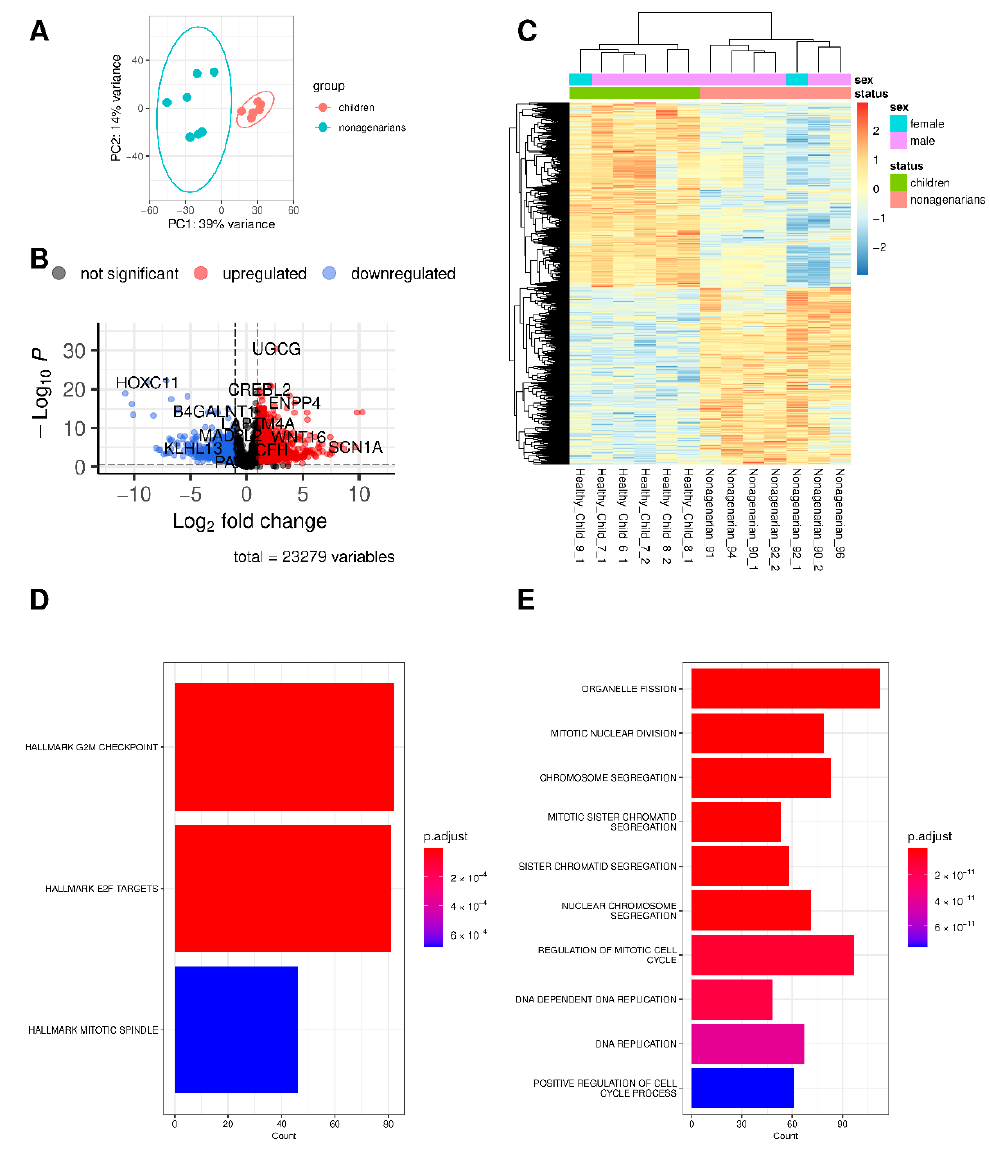
Figure 2. Comparing gene expression in RNA sequencing data of nonagenarians and healthy children (normal/chronological aging). ( A ) Principal Component Analysis (PCA): nonagenarians (blue dots) compared to healthy children (controls, red dots). ( B ) Volcano plot visualizing differentially expressed genes (DEGs): significantly upregulated genes are shown as red dots, significantly downregulated genes as blue dots, gray dots symbolize genes without significant changes in gene expression. ( C ) Heatmap and hierarchical clustering of the DEGs. ( D ) Bar plot of enriched hallmark pathwayhas. ( E ) Bar plot of GO enriched biological processes.